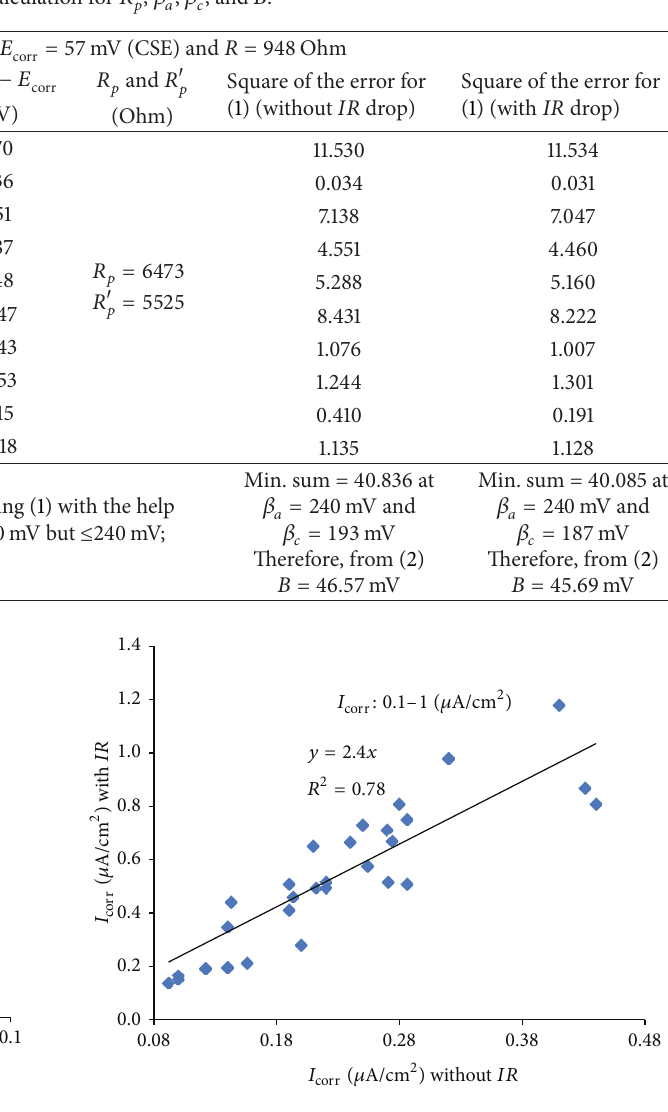
Figure 11: Correlation between 𝐼 0.1 to 1.0 𝜇 A/cm 2 sation for 𝐼 corr